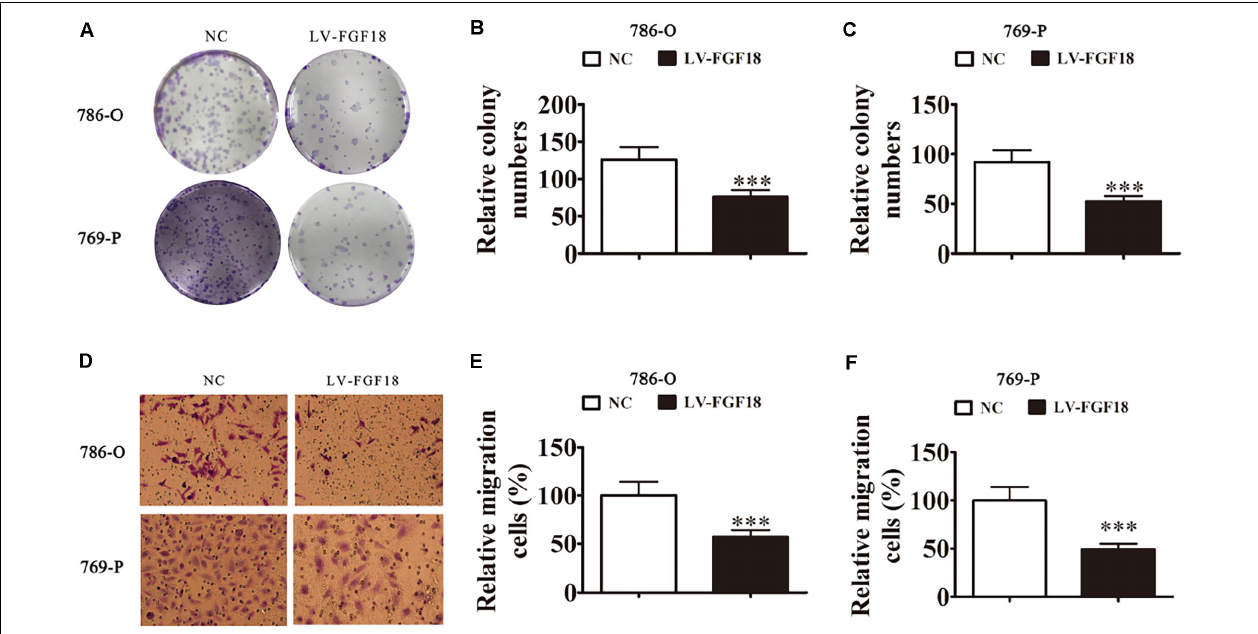
FIGURE 5 | FGF18 overexpression suppresses cellular invasion in ccRCC cells. (A) Cloning formation assays showed that the overexpression of FGF18 reduced the proliferation of both 786-O and 769-P cells. (B,C) The relative cloning numbers were calculated of both 786-O and 769-P cells. (D–F) Transwell assay showed that FGF18 overexpression reduced the migration ability of both 786-O and 769-P cells. Data of three experiments are presented as the mean ± SD, ∗∗∗ p < 0.001 versus NC.